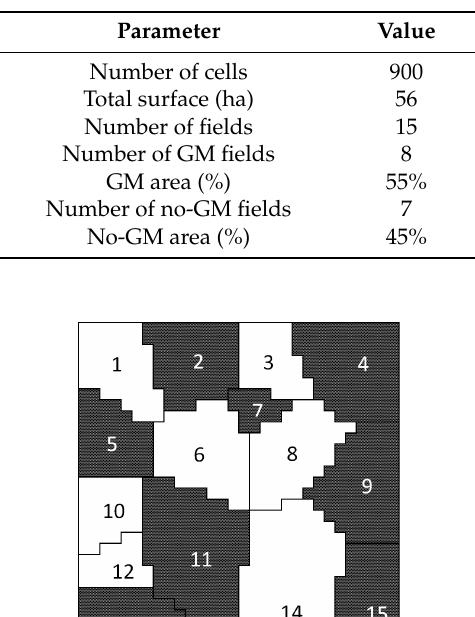
Table 2. Parameters defining the homogeneous and unconstrained landscape.